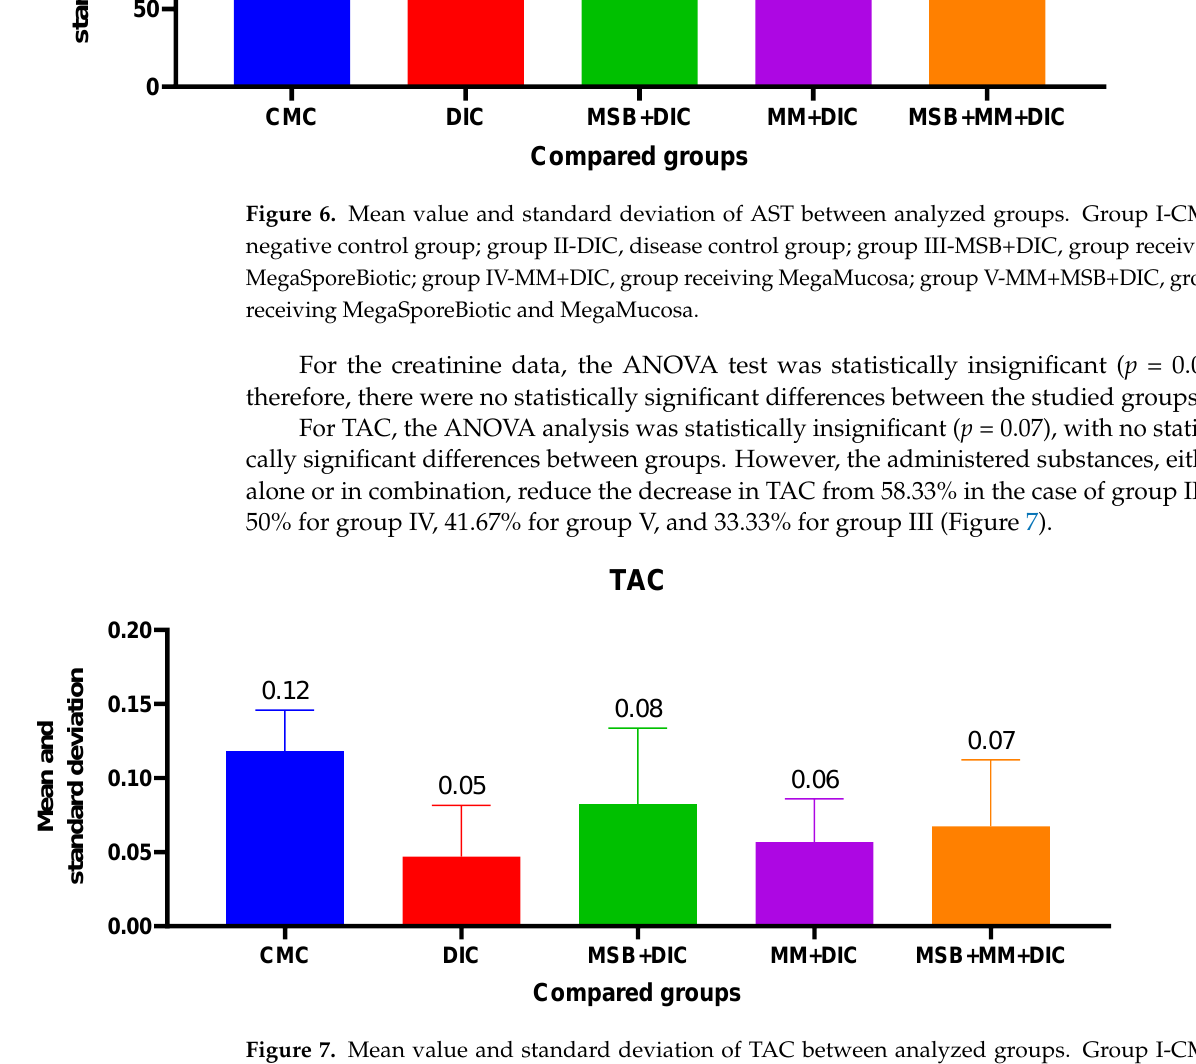
Figure 7. Mean value and standard deviation of TAC between analyzed groups. Group I-CMC, negative control group; group II-DIC, disease control group; group III-MSB+DIC, group receiving MegaSporeBiotic; group IV-MM+DIC, group receiving MegaMucosa; group V-MM+MSB+DIC, group receiving MegaSporeBiotic and MegaMucosa.